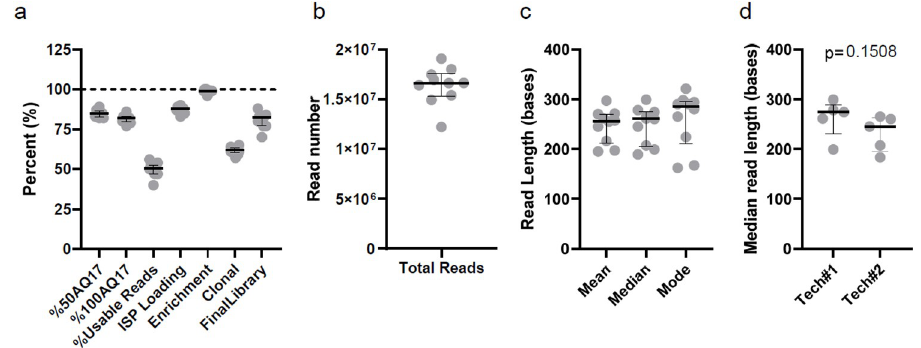
Fig 4. Distribution of run-level metrics from ten sequencing runs. a) Metrics for sequencing accuracy of test fragments (%50AQ17 and %100AQ17) and the percentage of reads usable for analysis. The latter is dependent on the percentages of ion-sphere particle (ISP) loading, template-positive ISP (enrichment), clonal ISP, and final library. b) Total reads usable for analysis. c) The mean, median, and mode of read lengths from 10 runs. d) The median read lengths stratified by technologists. Lines are medians and interquartile